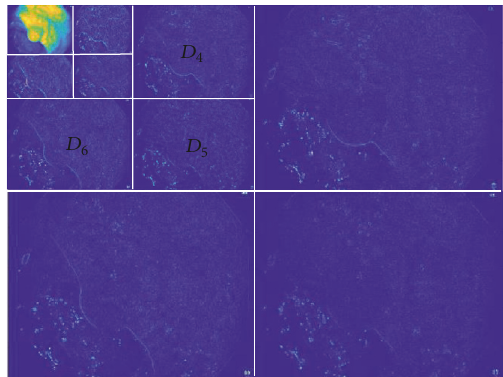
Figure 5: Three-level wavelet decomposition of red channel.